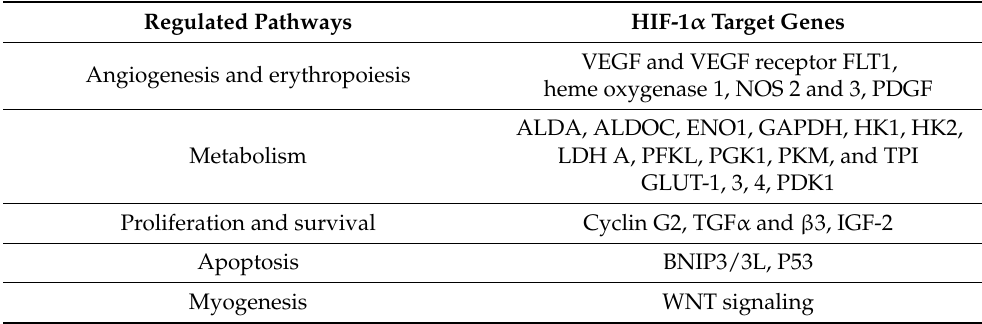
Table 1. Main HIF-1 α target genes and regulated